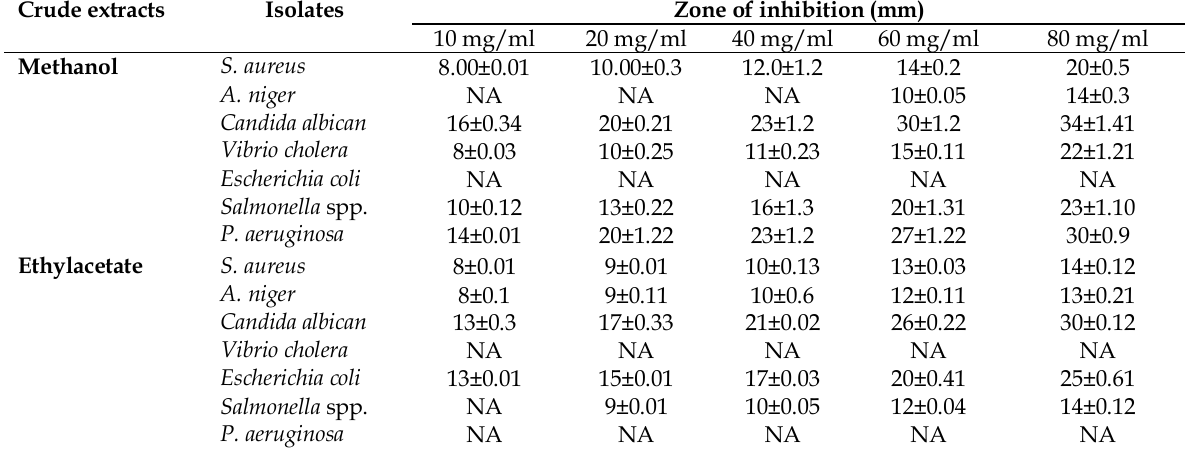
Table 3 : Antimicrobial Activity of methanol and ethyl acetate leaf extracts of Bryophyllum pinnatum against the human pathogenic bacteria by disc diffusion method. Crude extracts